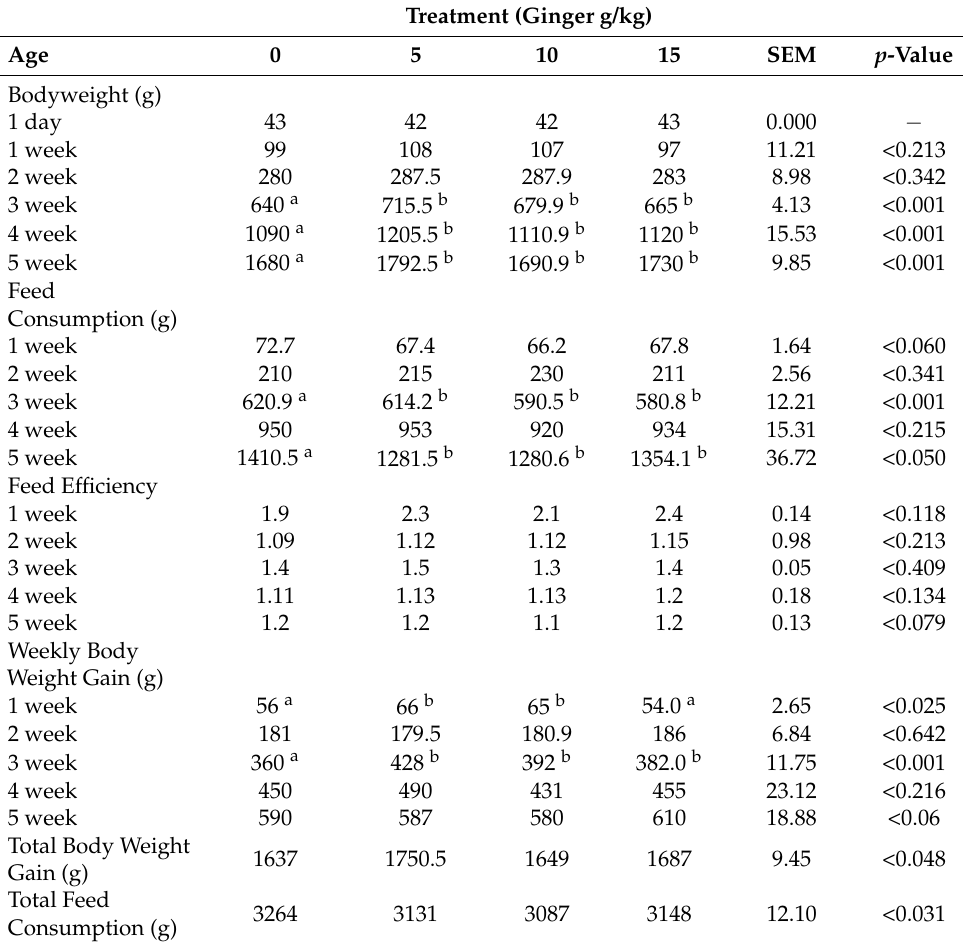
Table 2. The effects of different levels of ginger powder on body weight, feed consumption, feed efficiency, and weekly body weight gain of broiler